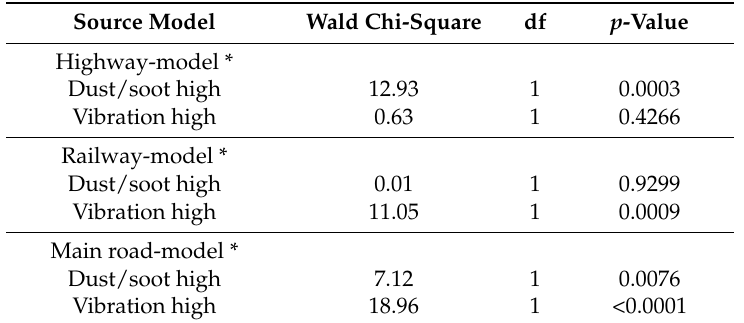
Table 3. The importance of perception of vibration and air pollution in traffic assessments. Extract from the logistic regression model